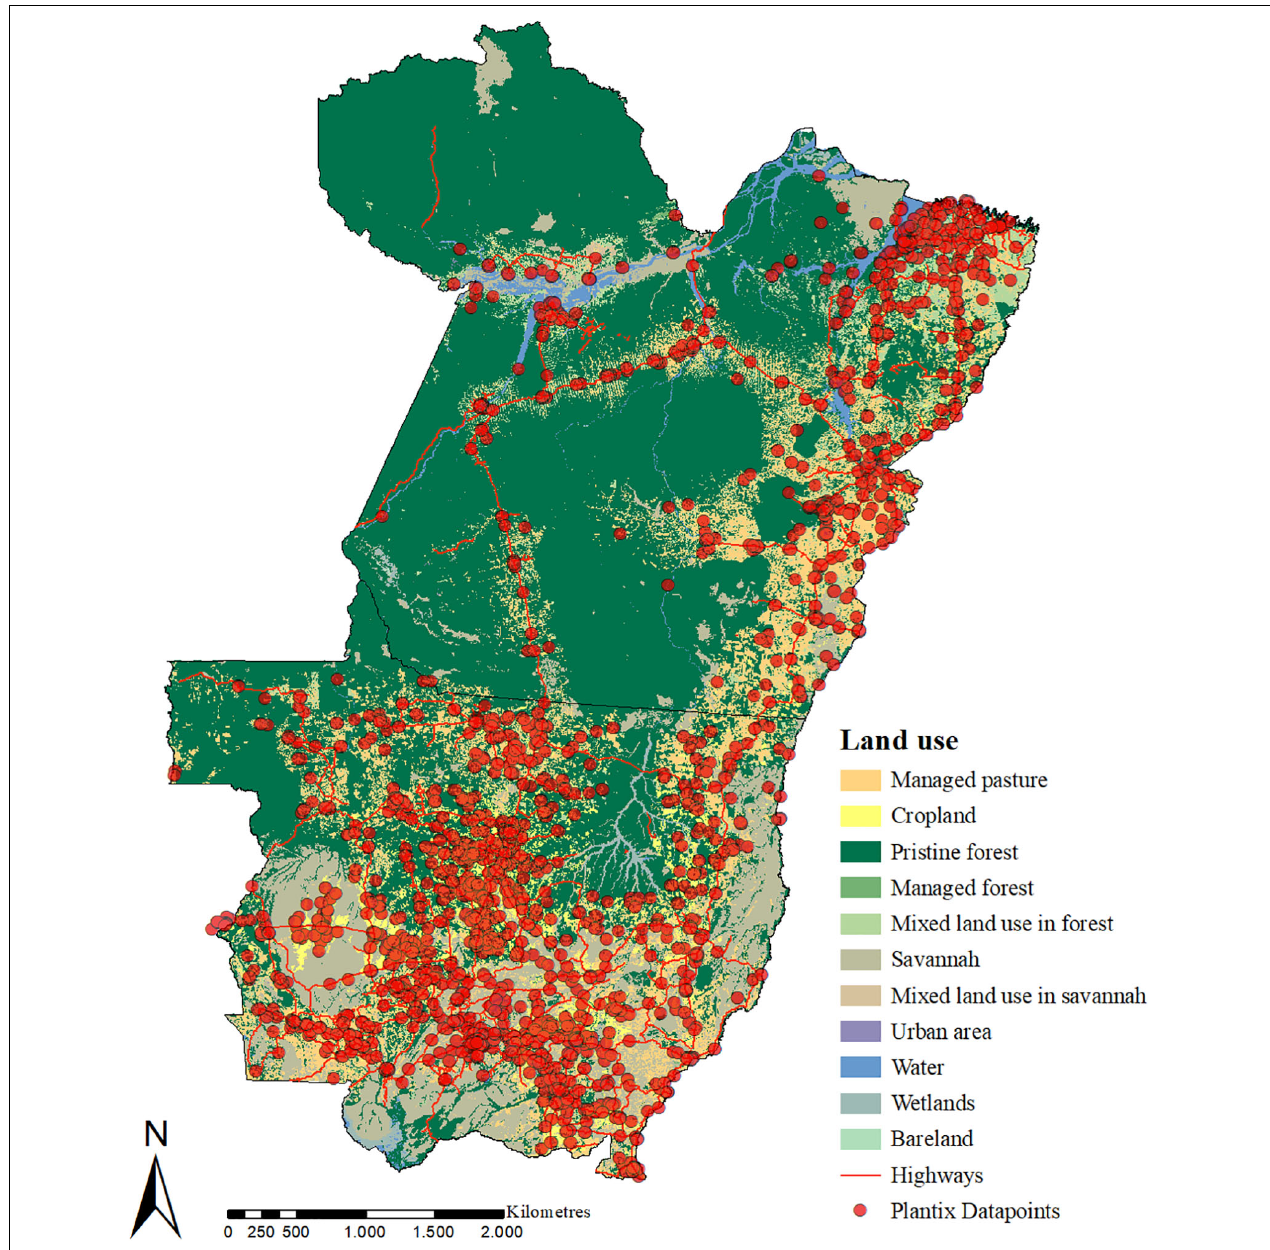
FIGURE 3 | Spatial distribution of P&A images collected by Plantix users in Mato Grosso and Pará, Brazil, between November 2016 and May 2020, and the main land-use types in the study area. Source of land use data: IBGE (2018). Map produced using ArcMap